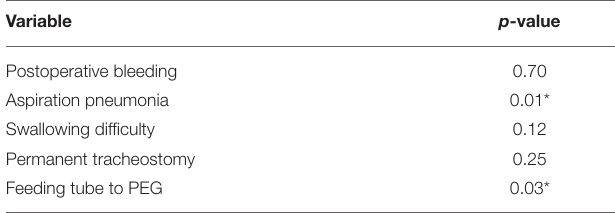
TABLE 5 | Comparison of different complications between TORS and